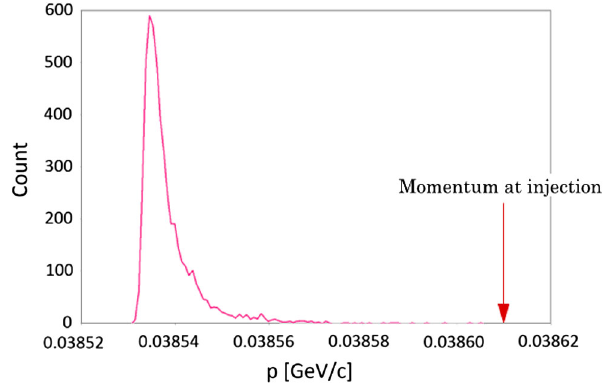
FIG. 21. Final momentum